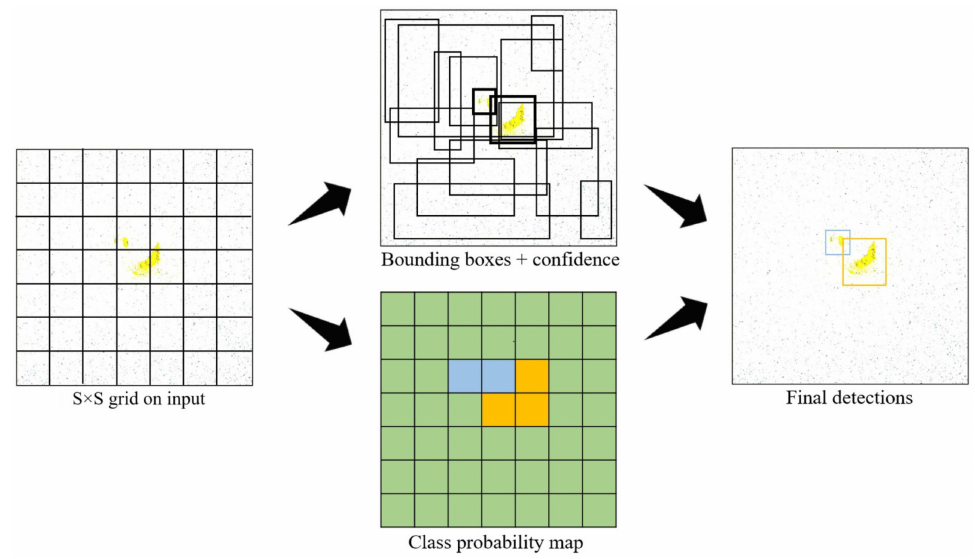
Figure 8. YOLOv5 was used to detect the light spot of the ECL images. In the Final detections, the orange and the blue frame are the boundary frames corresponding to the two light